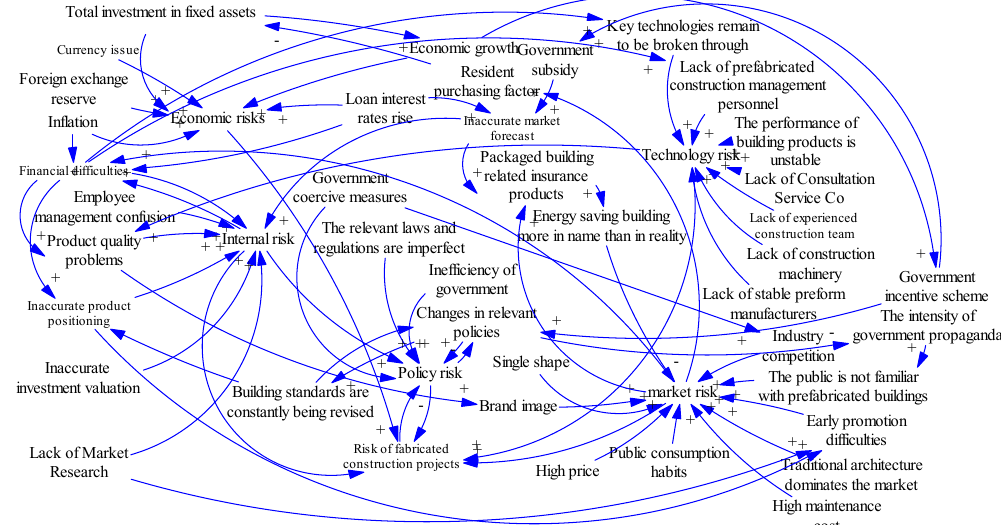
Figure 3. System dynamics risk identification feedback model diagram of a prefabricated construction project.